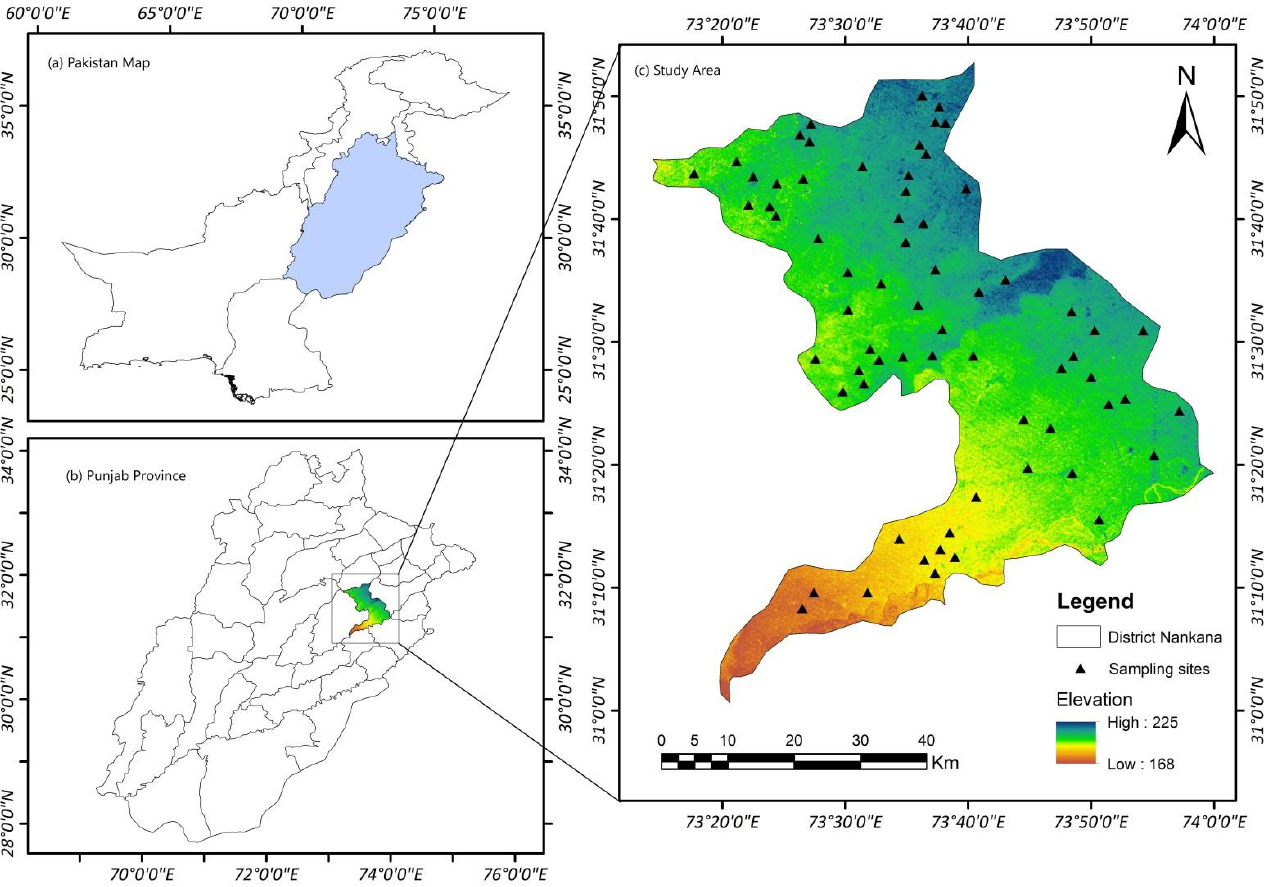
Figure 1. Geographical map of the study area with sample locations. Geology and